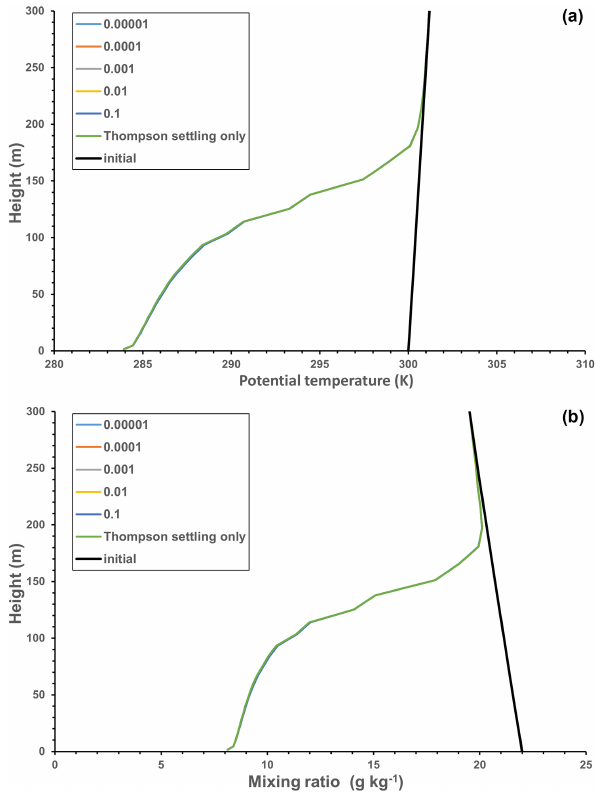
Figure 5. Sample 3-D WRF output at a fixed location over the Grand Banks, with different z 0c values (given in meters) in Q c tur- bulent deposition, (a) with and (b) without gravitational settling. Start time (day, month, year, and hour) was 7 January 2018 12:00Z, and results are for 7 January 2018, 18:00Z. Results are with the MYNN boundary layer and Thompson